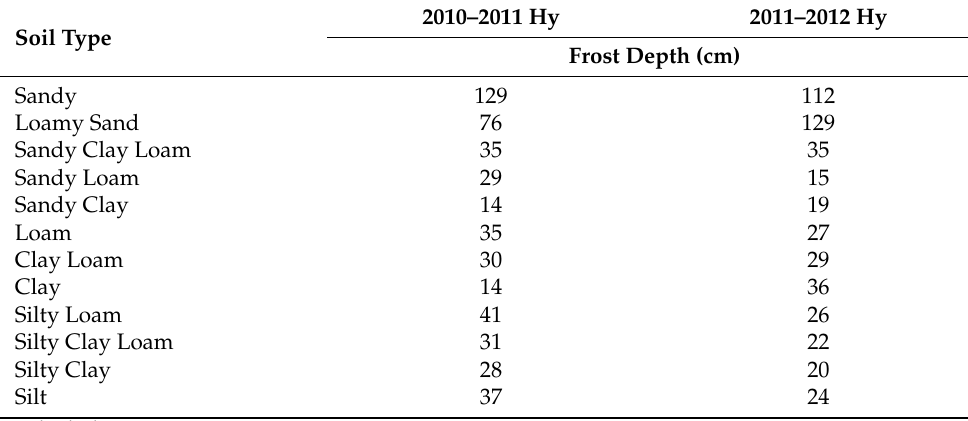
Table 5. Frost depth for both hydrologic years analyzed within first 5